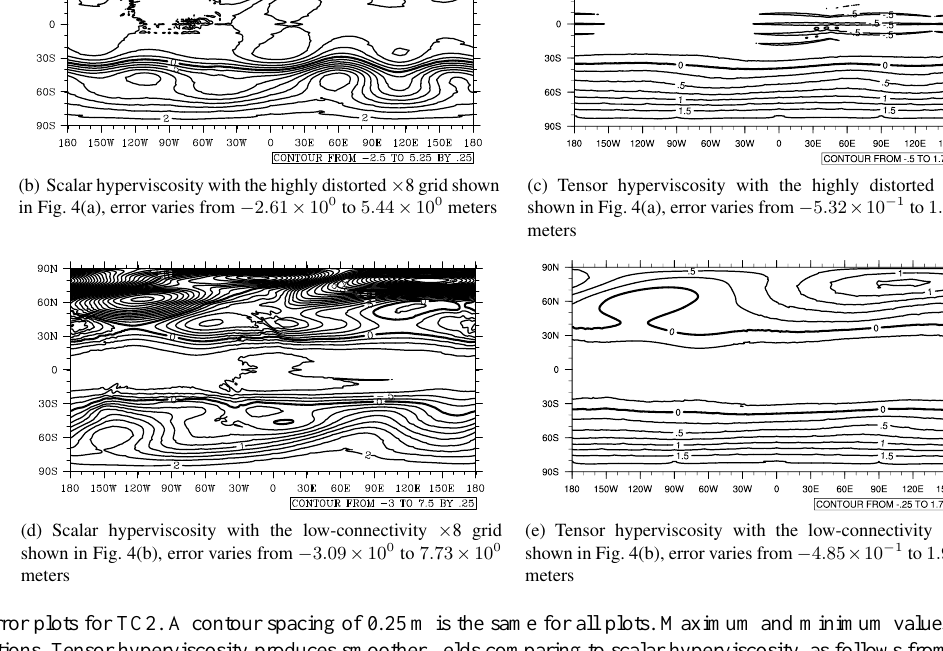
Figure 6. Error plots for TC2. A contour spacing of 0 . 25m is the same for all plots. Maximum and minimum values of error Eq. (15) are given in captions. Tensor hyperviscosity produces smoother fields comparing to scalar hyperviscosity, as follows from comparing pairs (b) , (c) , (d) , and (e) . In addition, the quality of the underlying grid significantly improves the outcome around the refined region when using scalar hyperviscosity, as seen by comparing (b) and (d) . Contrary to scalar hyperviscosity, tensor hyperviscosity is more robust with respect to mesh quality, as follows from comparing (c) and (e) . Simulations (c) and (e) with tensor hyperviscosity also exhibit a substantial error reduction in the vicinity of the refinement compared to the coarse uniform resolution in (a)